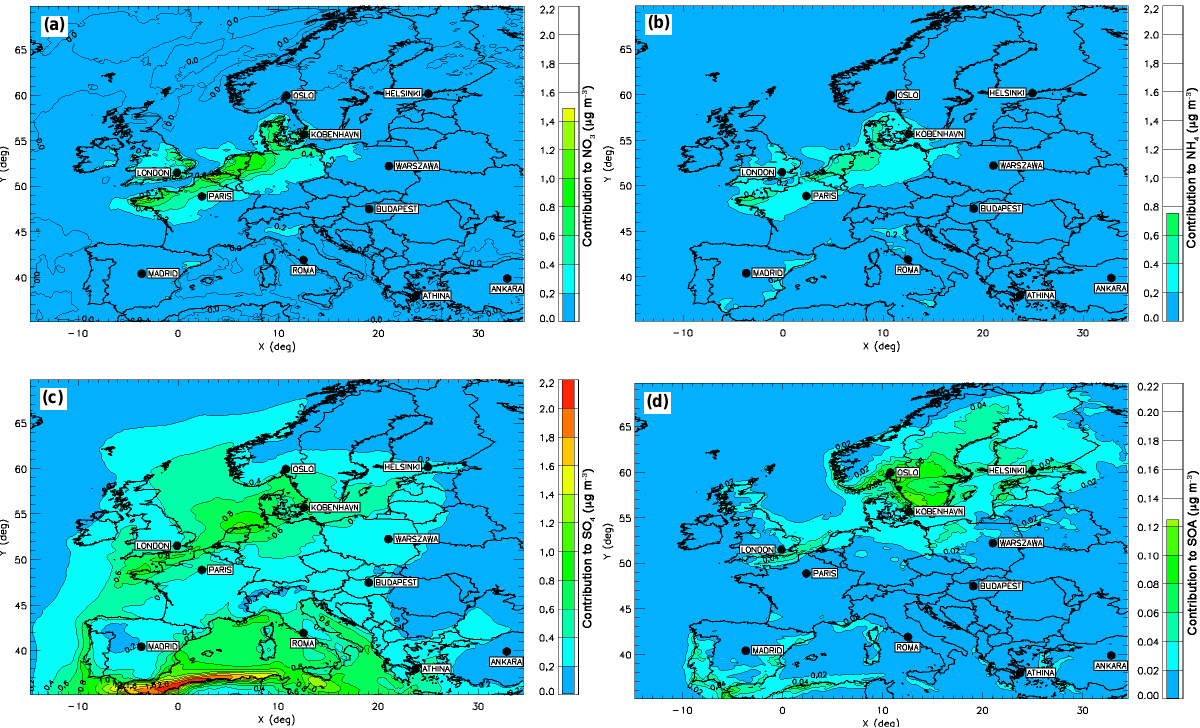
Figure 6. Contribution of ship emissions (µgm − 3 ) to the secondary aerosol concentration: (a) NO 3 , (b) NH 4 , (c) SO 4 and (d) SOA in summer 2006 (base case − no ship). Note that the scale in (d) is 10 times smaller than the